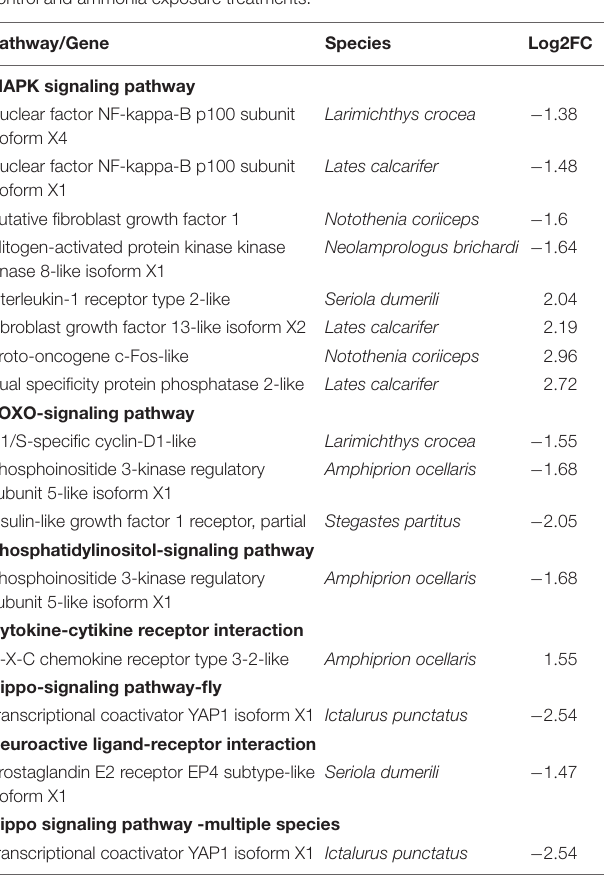
TABLE 5 | List of DEGs involved in environmental information processing in control and ammonia exposure treatments.